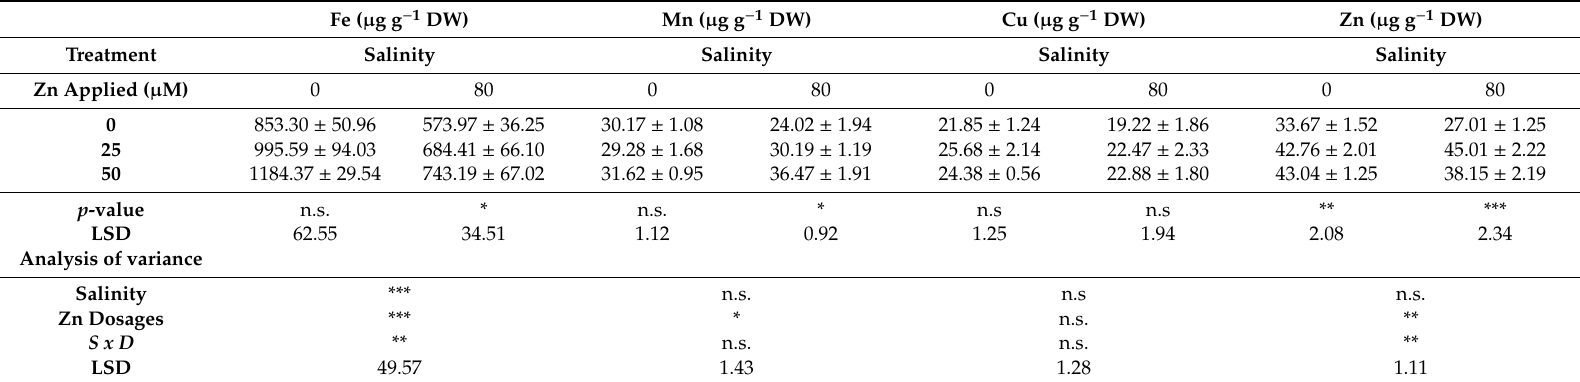
Table 5. Microelement concentrations of roots of pak choi plants grown with di ff erent salinity and / or Zn treatments. Values are means ± SE ( n =